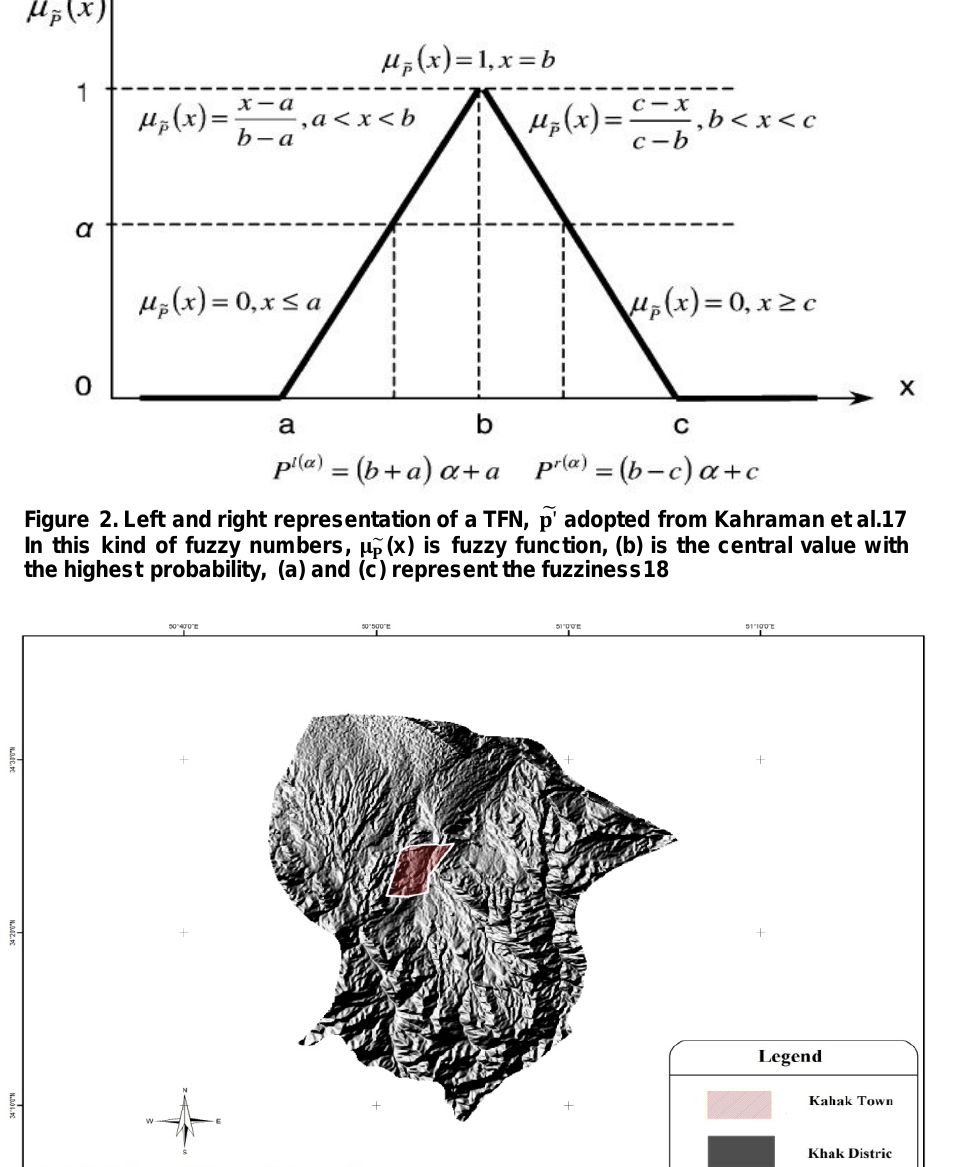
Figure 3. Position of the Kahak